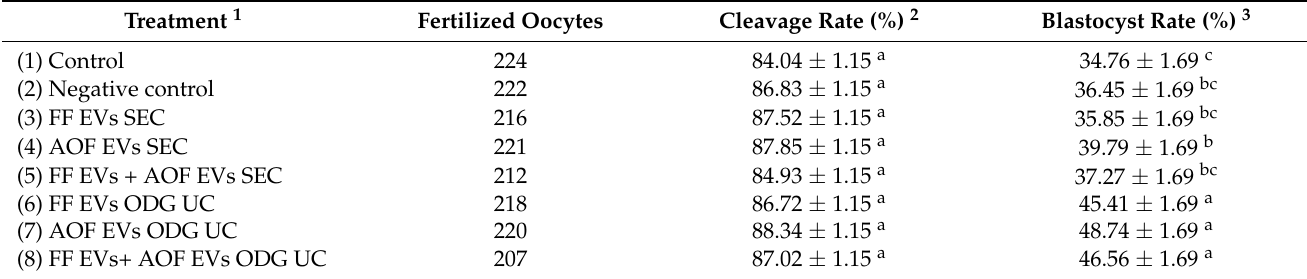
Table 2. Effects of the experimental treatments on the in vitro embryo